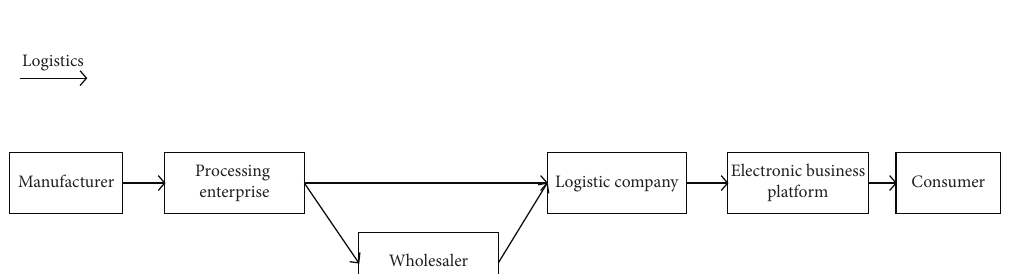
Figure 2: Infrastructure of blockchain information platform.